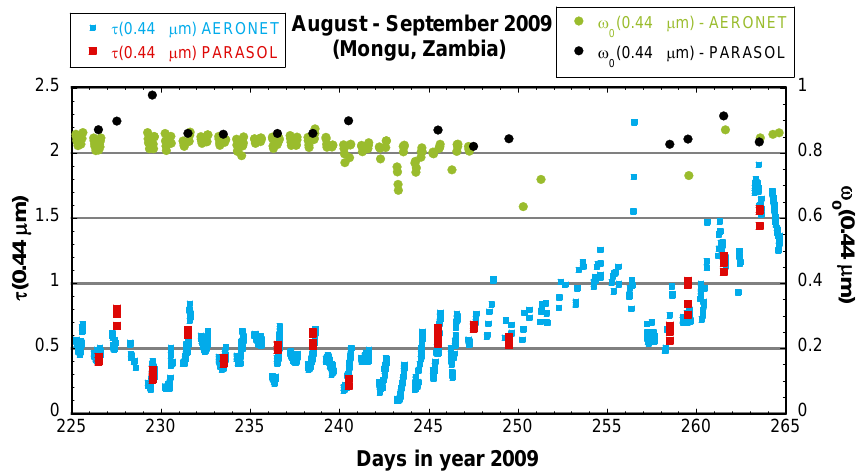
Fig. 20. The comparison of τ (0.44µm) and ω 0 (0.44µm) retrieved from POLDER/PARASOL during August–September 2009 over Mongu with the corresponding values provided by AERONET.